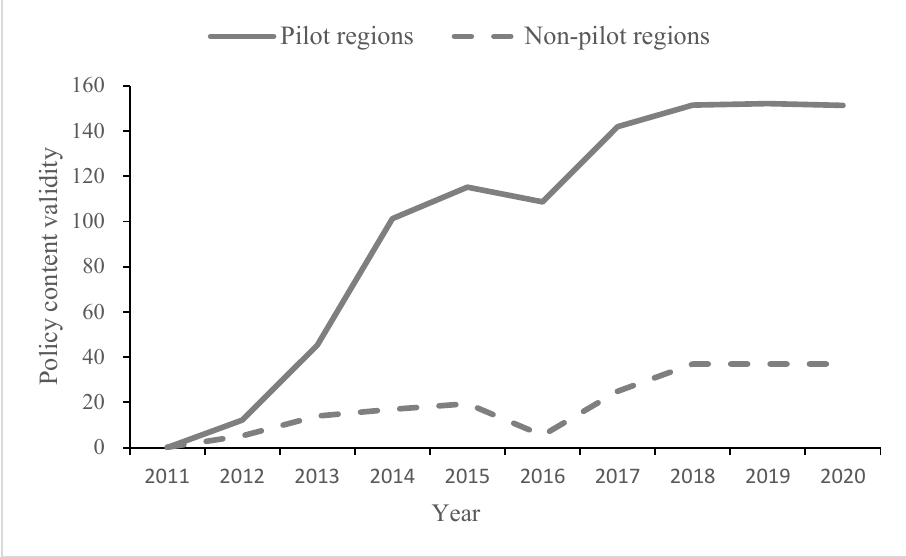
Figure 3. Content validity of CET policies in pilot and non-pilot regions (2011–2020). (Note: the data supporting the figure were calculated by the authors).